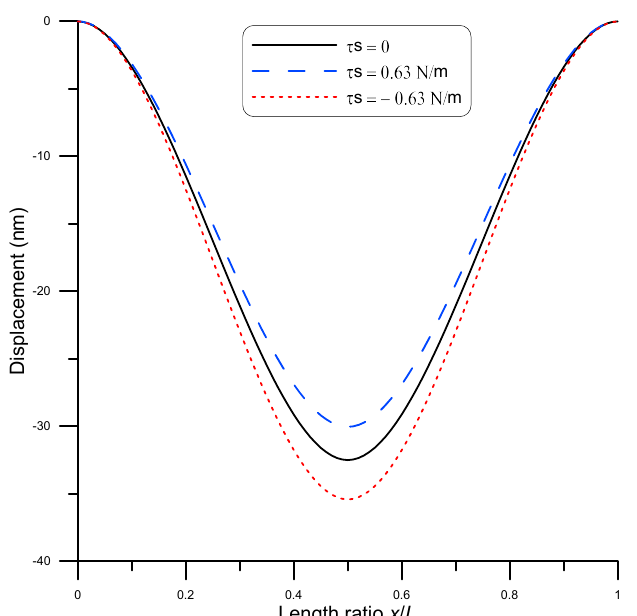
Figure 6. Nanobeam displacement under 62 nN point load at mid-span for the cases of τ s = 0 (solid line), τ s = 0.63 N/m (blue dashed line), and τ s = − 0.63 N/m (red dotted